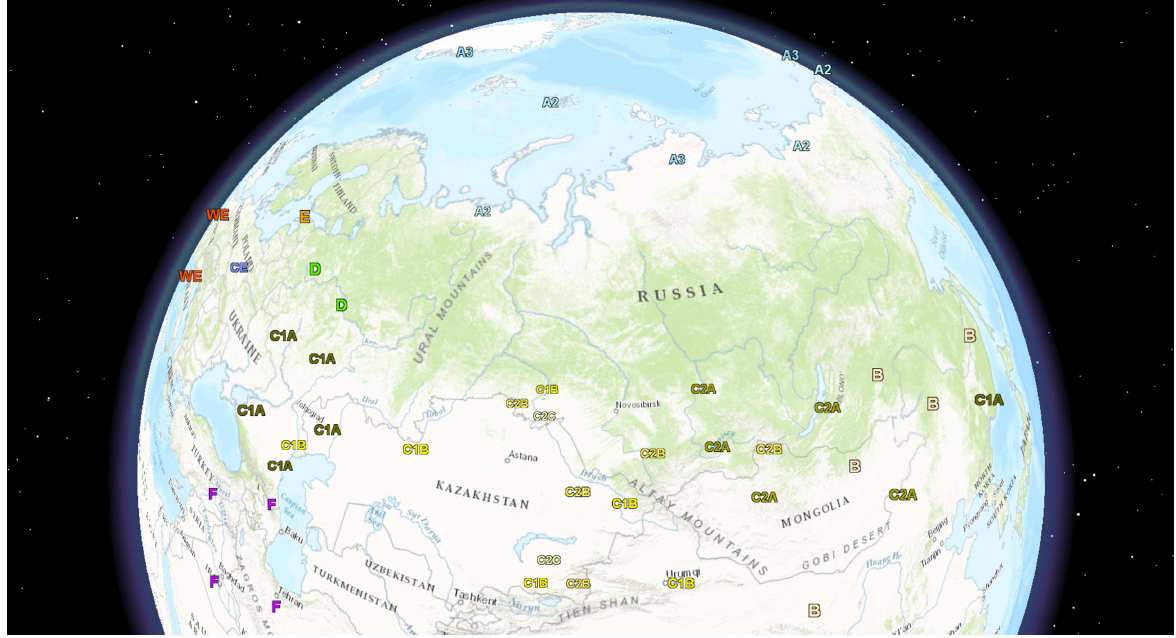
Fig 2. Distribution of rabies virus genotypes in the Russian Federation and neighboring countries. Geographical distributionof rabies virus phylogenetic groupsis indicated. Precisionis limited by the first-level administrative districts.